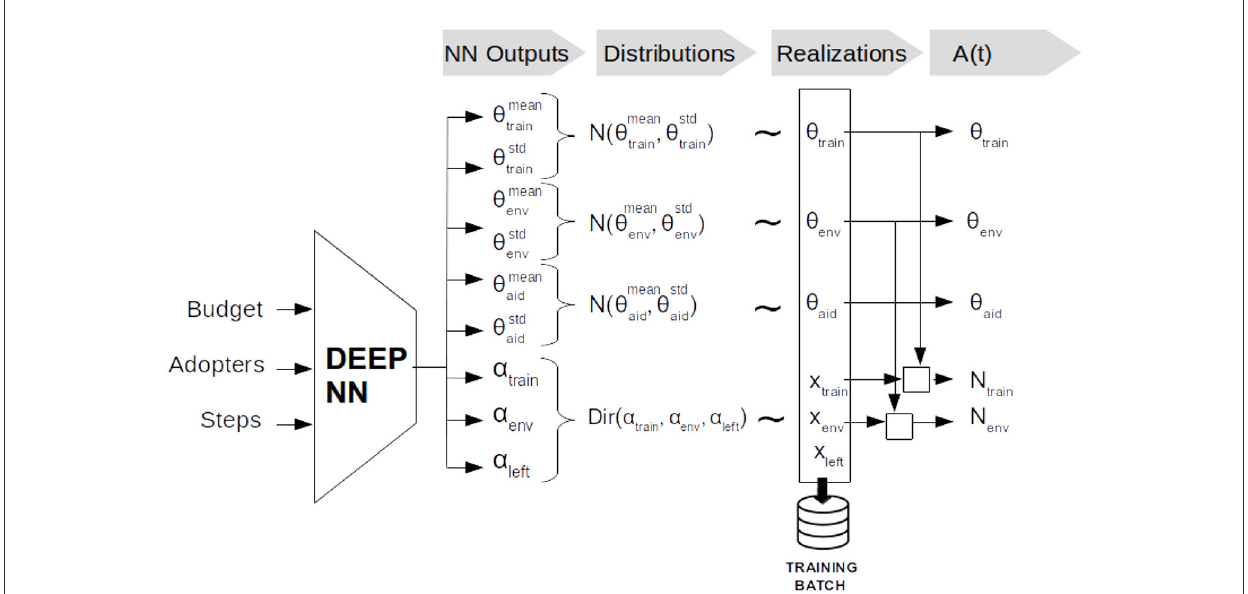
FIGURE3 Schematic overview of the process from the NN input to the institution policy actions. (1) The NN gets as input the current state of the environment. (2) The outputs of the NN are used to define some parametric distributions over actions in the current state. (3) The distributions are sampled to obtain realizations for the current iteration. (4) Policy actions are defined from the